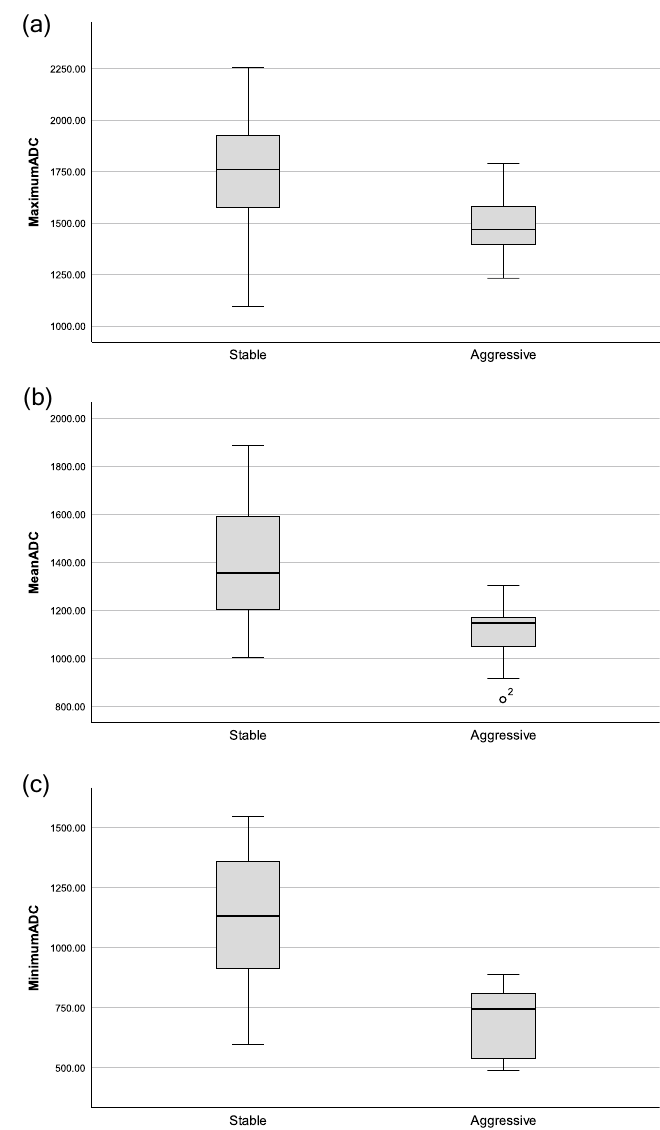
Figure 1. Comparison of ADC values between stable and aggressive chordoma (10 –6 mm 2 /s). There were significant differences between groups in ( a ) maximum ADC ( P = 0.012), ( b ) mean ADC ( P < 0.001), and ( c ) minimum ADC ( P <